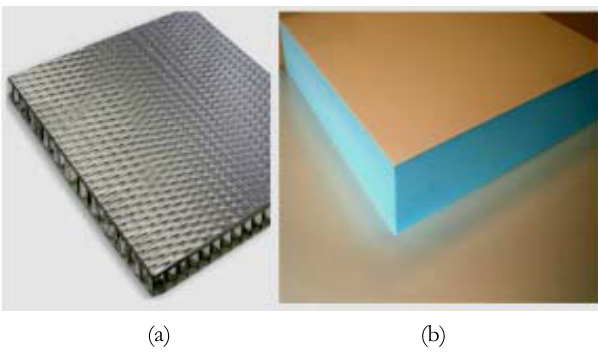
Figure 1: Sandwich panel with core, a) Honeycomb b) Foam.